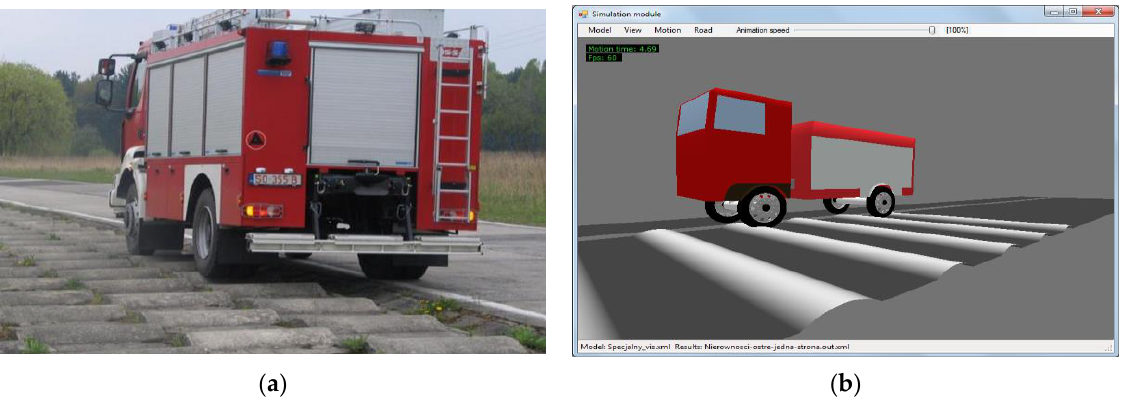
Figure 24. The examples of road tests with computer simulation performed by authors: ( a ) experimental tests, ( b ) computer simulations.